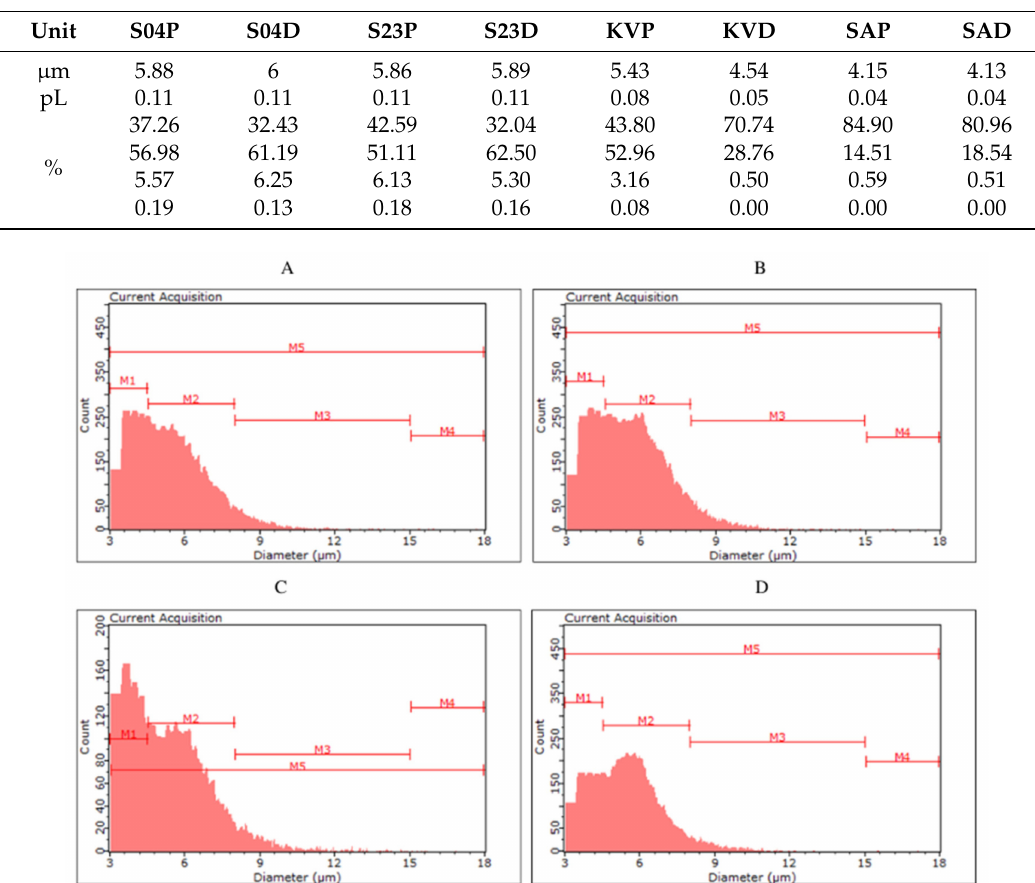
Table 4. Characteristics of the brewing yeast cell biomass using Scepter Cell Counter.